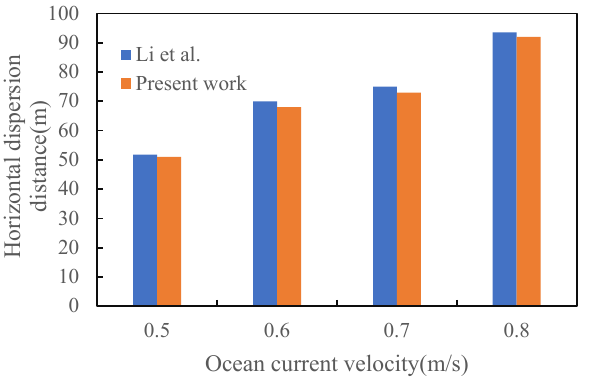
Figure 3. Validation of numerical simulation model against simulation results in Li et al. (2018) [28].